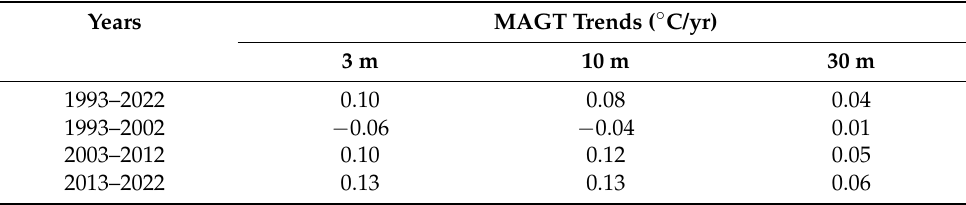
Figure 7. Mean annual permafrost temperature in the stone ridge (Site 1) at depths of 3 m ( a ), 10 m ( b ) and 30 m ( c ) in 1993–2022. Table 5. Trends in the MAGT for the entire period and for decades at the stone ridge. (Site 1)